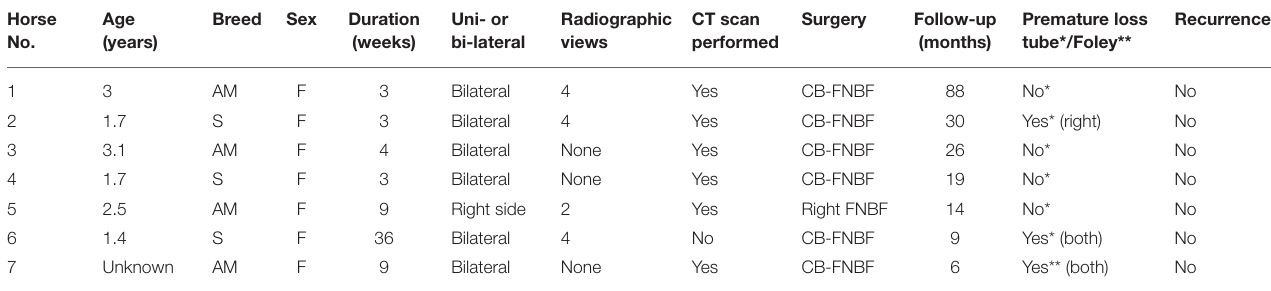
TABLE 1 | Summary data for horses undergoing treatment of idiopathic sino-nasal obstruction. Horse No.